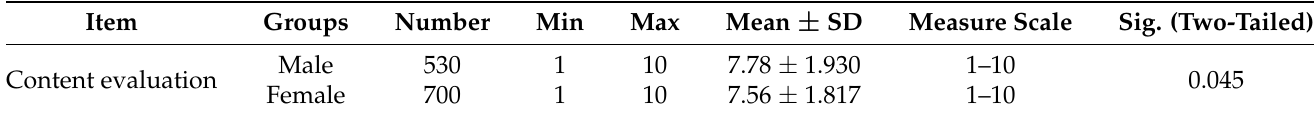
Table 4. Content evaluation of public-interest SMS between males and females.